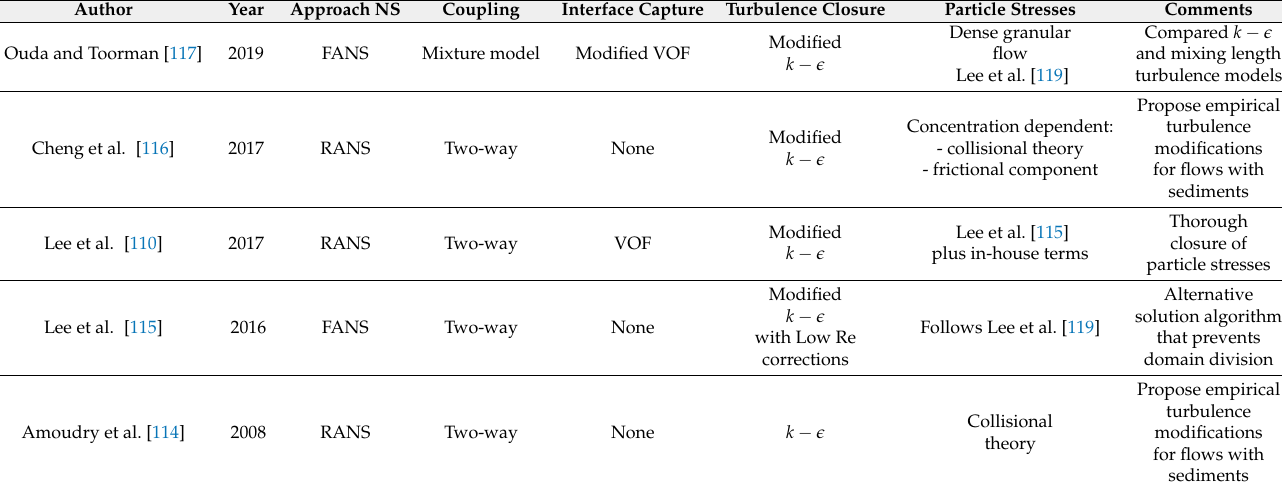
Table 3. Summary of the most recent and leading works that use the full multiphase approach to model the wave–structure– seabed